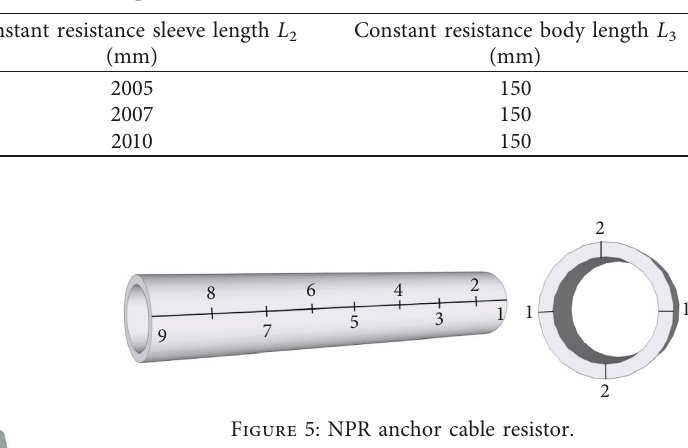
Table 1: Anchor cable parameters.